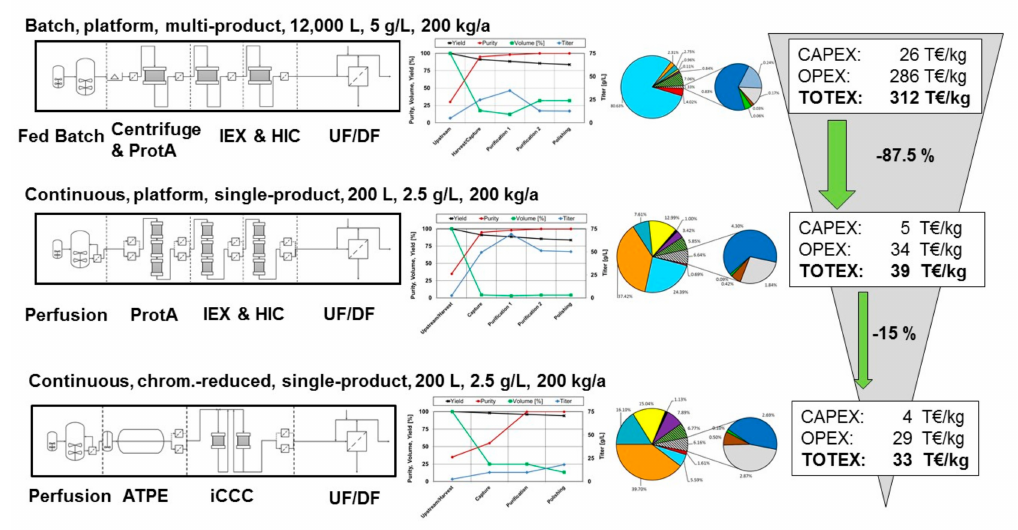
Figure 1. Schematic cost comparison between batch and continuous operational mode for the manufacturing of monoclonal antibodies [6]. ProtA (protein a chromatography), IEX (ion exchange chromatography), HIC (hydrophobic interaction chromatography), UF (ultrafiltration), DF (diafiltration), ATPE (aqueous two-phase extraction), iCCC (integrated counter-current chromatography), CAPEX (capital expenditures), OPEX (operating expenditures), TOTEX (total